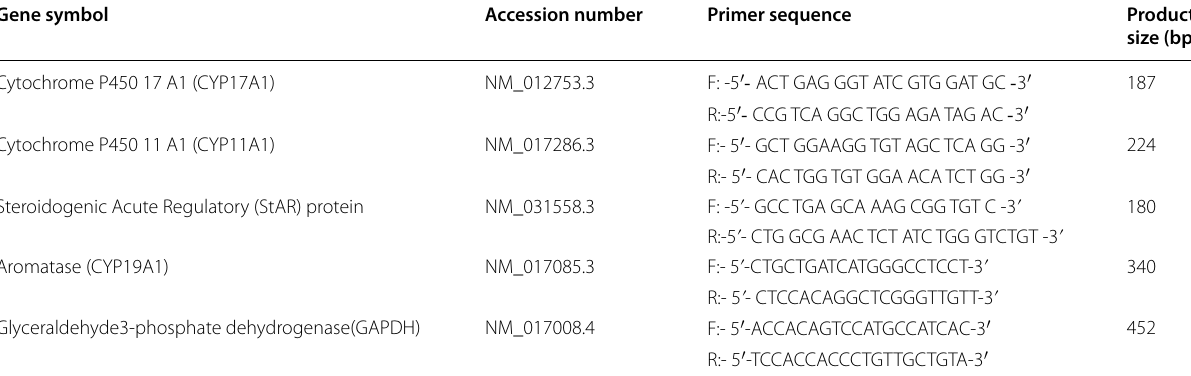
Table 1 Primers sequences used for qRT-PCR